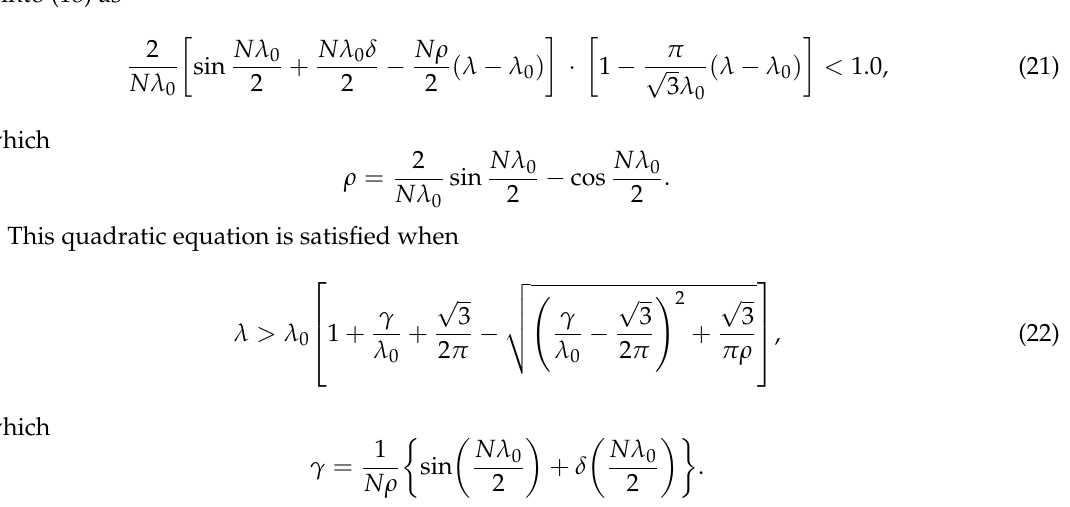
Figure 5. An example illustration of the sinc function and the cosine function terms of (18) on λ -axis. The proposed stability bound can be simplified into a quadratic equation by substituting (19) and (20) into (18) as